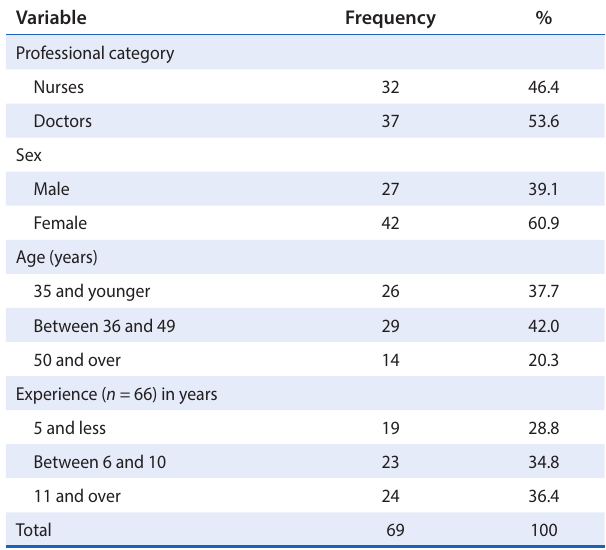
Table 1: Demographic profile of the